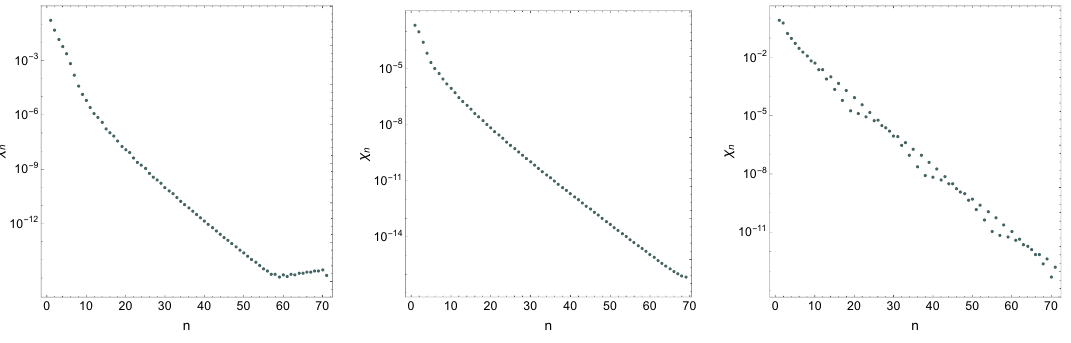
Figure 7 . Convergence plots of the functions ~ h xy ; ~ h tx and ~ ’ 1 for the lowest QNM for k=T = 0 : 14 ; (cid:12) = 60 and T=m = 0 :